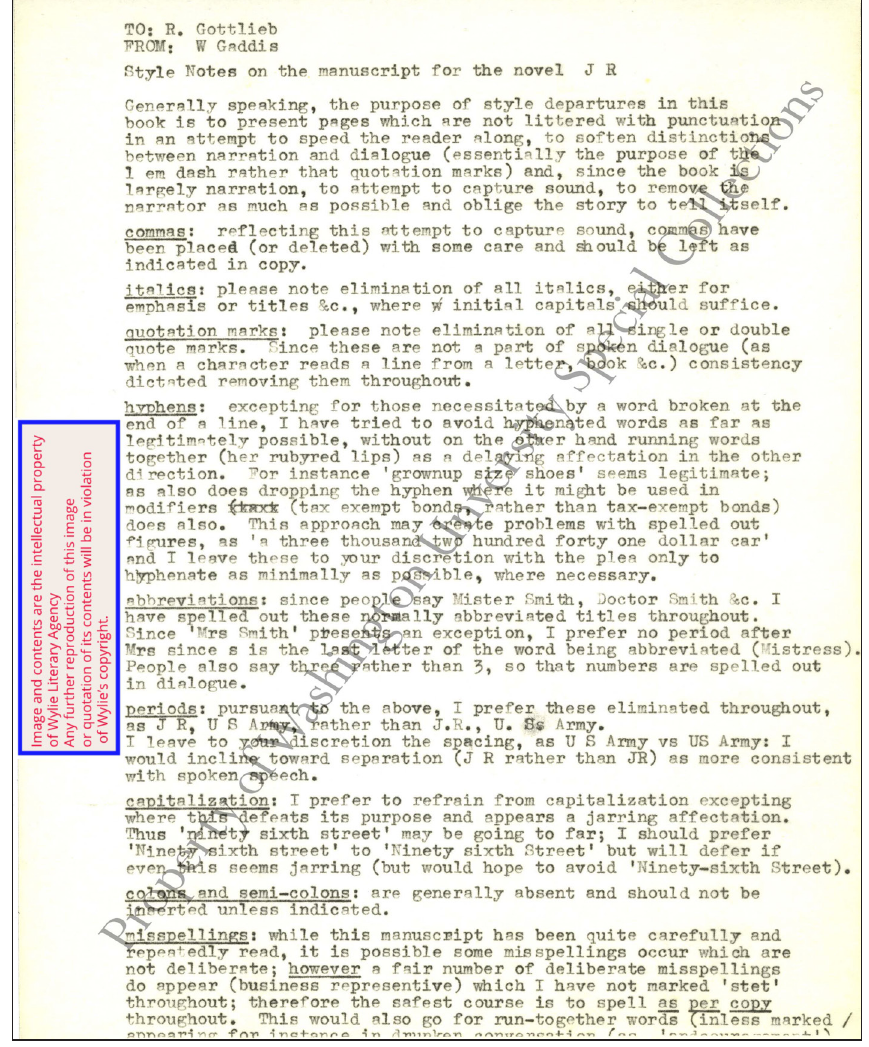
Figure 3: Gaddis’ Style Guide for J R ’s